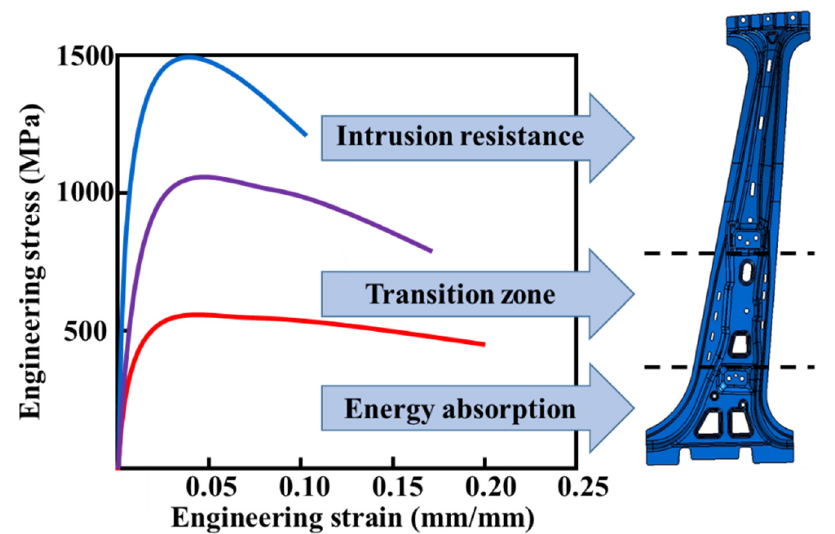
Figure 1. Hot-stamping process of UHSS.